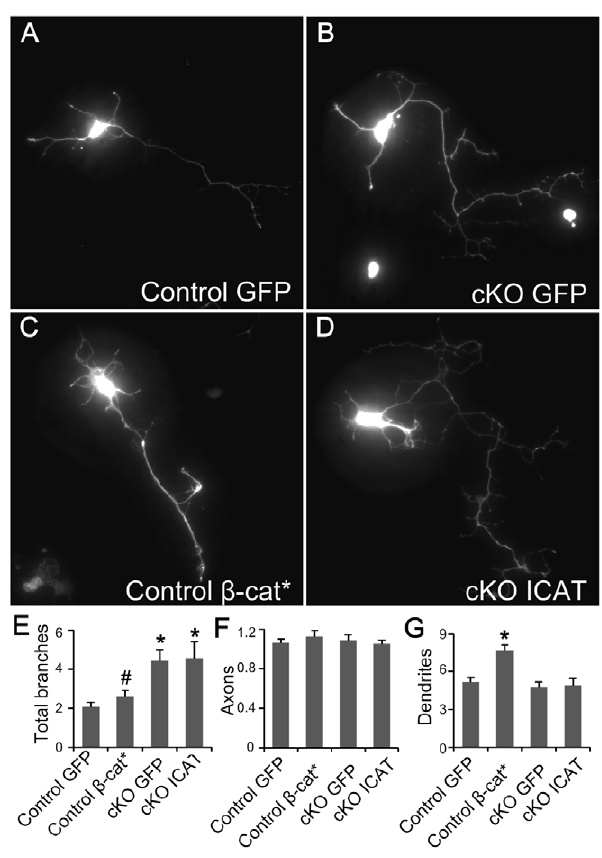
Figure 4. Stabilized b -catenin does not induce branch forma- tion. (A–D) Control cortical neurons expressing GFP (A) or stabilized b - catenin ( b -cat*, C), and APC cKO cortical neurons expressing GFP (B) or ICAT (D). Cortical neurons were cultured for 4 days in vitro after dissociation and transfection. (E) The number of total branches per neuron. (F) The average axon number per neuron. (G) The average dendrite number per neuron. *: p , 0.005, when compared with GFP expressing control neurons. # : P , 0.005, when compared with GFP expressing APC deficient neurons. n . 120 neurons for each conditions from three independent experiments. Data are presented as mean 6 SEM.